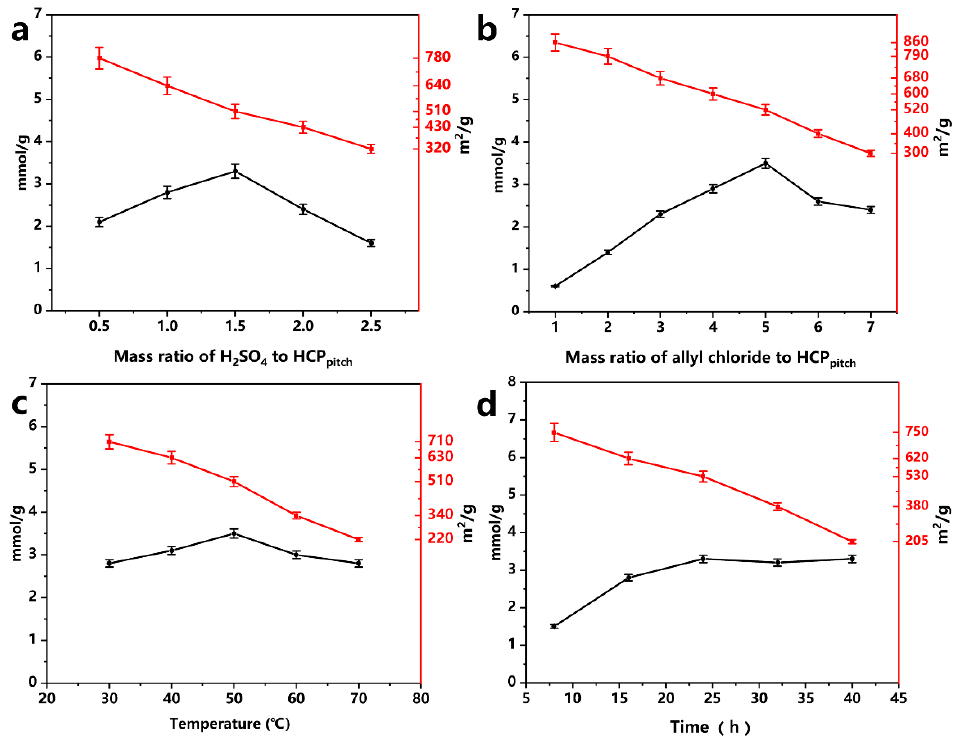
Figure 6. Impacts of four variables on the chloromethylation efficiency and the variation of specific surface area. ( a ) Additive amount of H 2 SO 4 , ( b ) additive amount of allyl chloride, ( c ) reaction temperature, ( d ) reaction time.